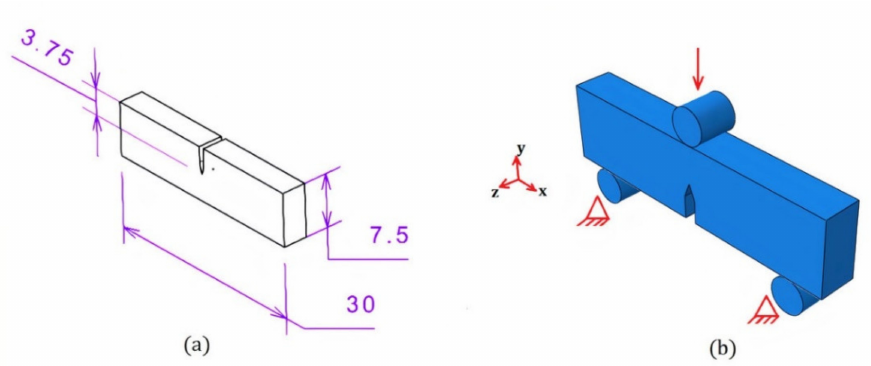
Figure 3. ( a ) Specification of three-point bend test specimen (all units are in mm) ( b ) model of three-point bend test specimen.